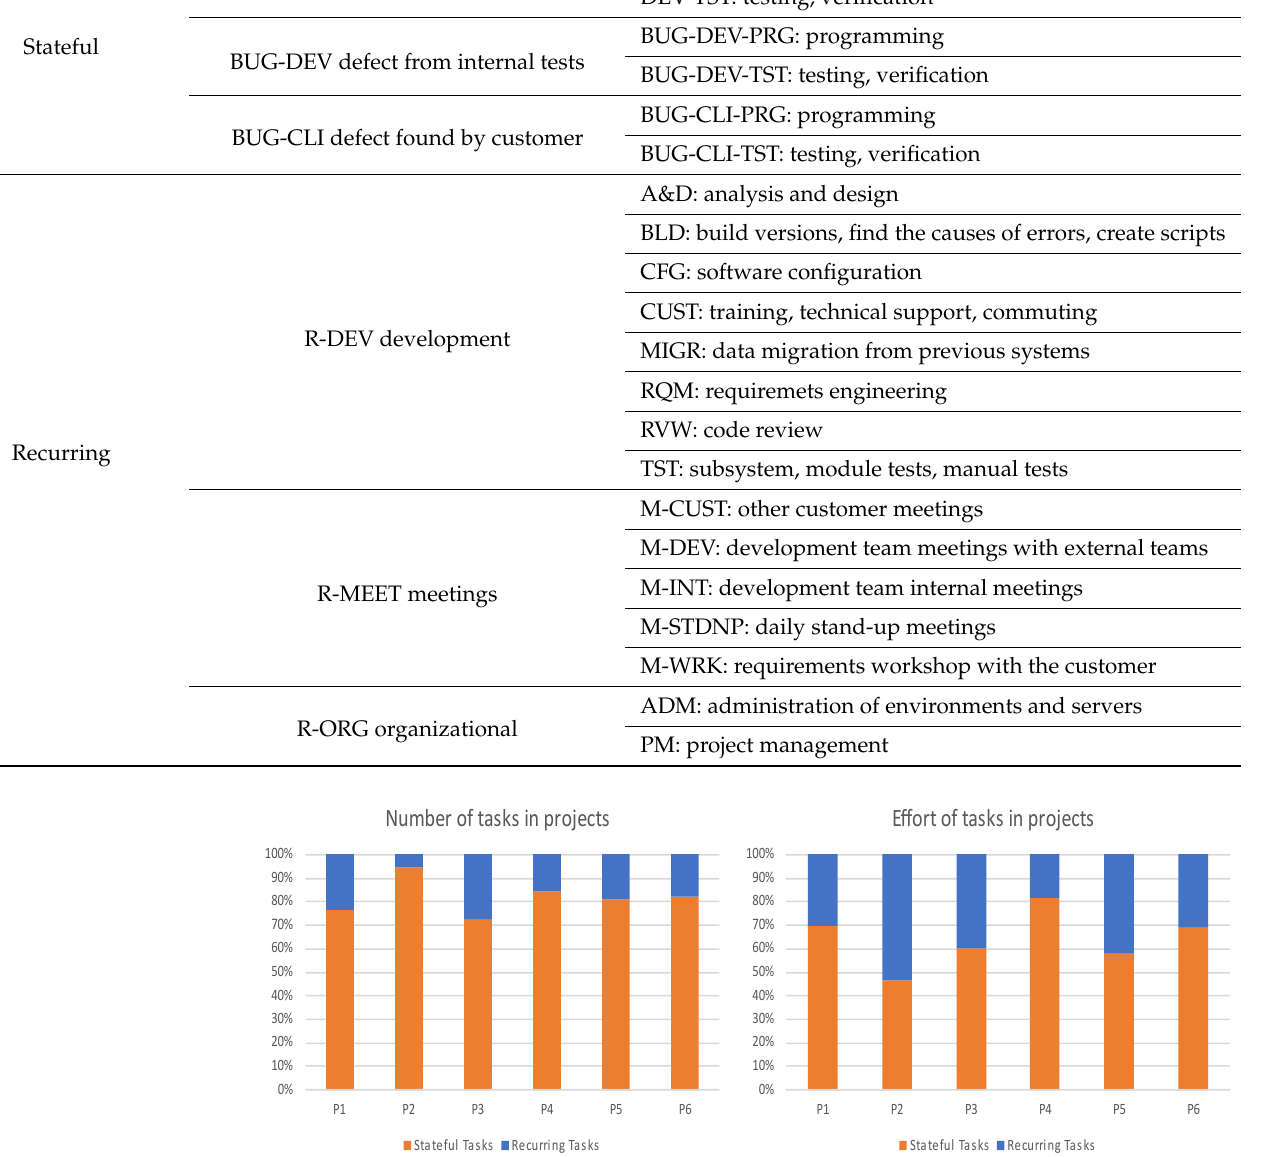
Table 2. Types of stateful and recurring tasks used by the model.